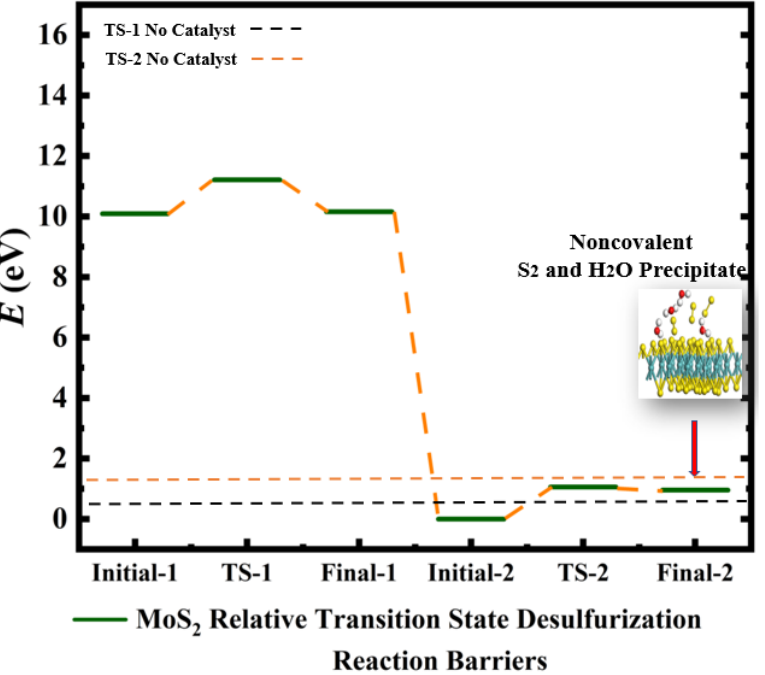
Figure 4. Calculated relative initial, transition, and final states reaction barriers of step 1 and step 2 for the oxidation–reduction of sulfur dioxide to elemental sulfur by utilizing the doubly ‐ charged catalyst MoS 2 represented by the dark green bars. White inset: geometrically optimized final state 2 (Final ‐ 2) of MoS 2 with noncovalent precipitated S 2 and H 2 O. Sulfur, carbon, oxygen, and hydrogen are represented by the yellow, gray, red, and white spheres, respectively.